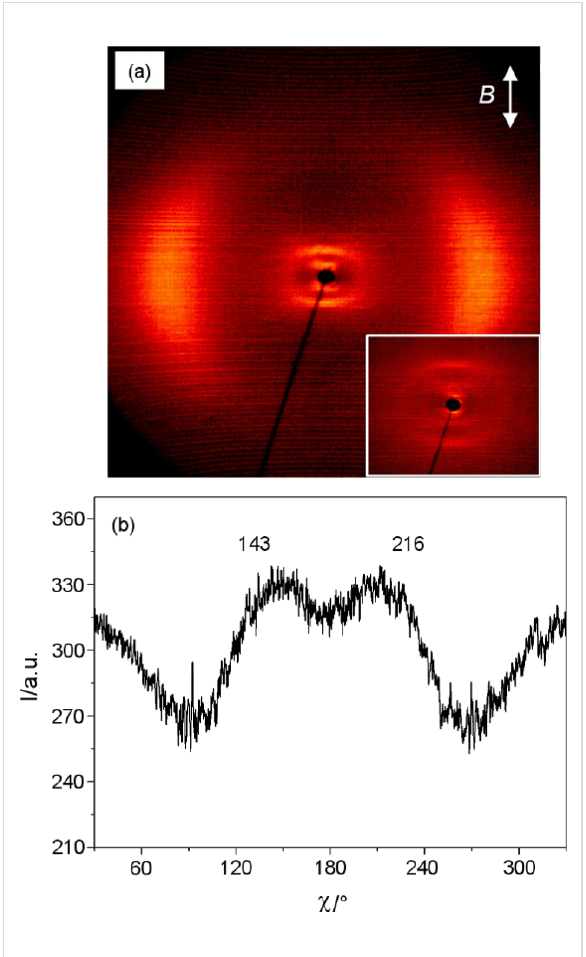
Figure 7: XRD pattern of a magnetic-field-aligned sample of the N cybC phase of the dimesogen Thia-Ox/10: (a) diffraction pattern at T = 150 °C (inset = small-angle scattering); (b) χ -scan over the small- angle scattering (2 θ = 2.5–5.0°). Besides the scattering at d = 2.5 nm there is a second very weak scattering with a maximum at a smaller θ -angle, corresponding to approximately twice the d -value. This would indicate a monolayer structure in the cybotactic clusters, similar to that described for Thia-Ox/5 . It is unlikely that the much more intense scat- tering at a higher d -value represents the second order of the weak reflection. A possible explanation could therefore be a heterogeneous structure of the sample, probably provided by the interaction of the cybotactic clusters with the surface of the capillary, in which the majority represents the intercalated structure described in the text and the minority is formed by a monolayer structure as found for Thia-Ox/5 . The proposed formation of a SmC surface layer is basi- cally in line with texture observations made for compound Thia-Ox/5 (see Figure 8c,d) in which no significant change of the texture is found at the N cybC -to-SmC transition. It could be expected that the energetic difference between these two distinct types of layer structures is small, and hence variation of the cluster size under the influence of surface interactions could have an effect on the